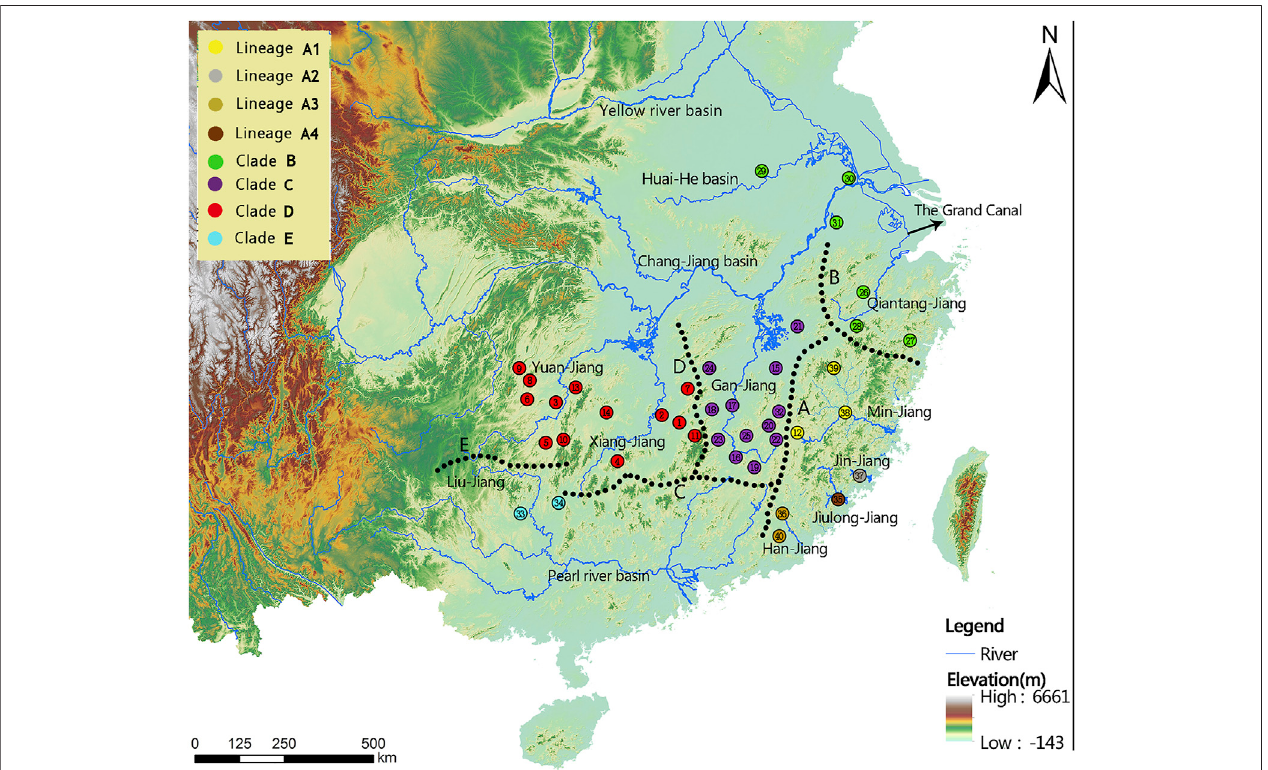
FIGURE 1 | Sampling localities (1-40) and geographical barriers (A – E) within the T. albomarginatus species group. Distinct colors denote the same lineage membership as used in Figures 2 – 6 . A, Wuyi Mountains; B, Huangshan-Tianmushan Mountains; C, Nanling Mountains; D, Luoxiao-Mufu Mountains; E, Miaoling Mountains.